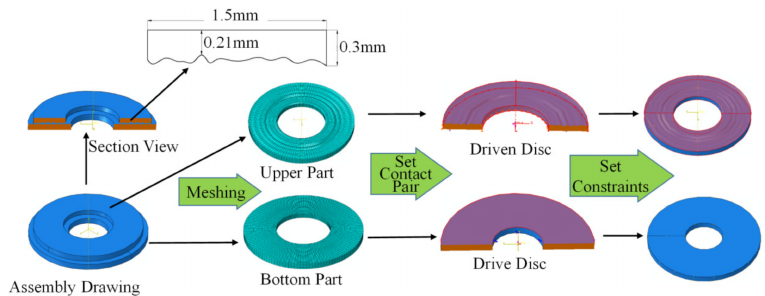
Figure 2. Modeling process of the friction pair. The 3D rough surface with grooves is generated by a 360-degree rotation of one 2-D topographic curve obtained by the fractal feature extraction above, and the distance between the rotational axis and the inner radius edge is 1.0 mm. We import the 3D rough surface model into the finite element analysis software ABAQUS as the upper part. The bottom part is simplified into a smooth disc. There is a clearance between the rough surface upper part and the bottom part when assembling. So, the two components constitute the whole ABAQUS friction pair model. The upper part has 16,640 elements, and the mesh type is C3D8R; the bottom part has 4914 elements, and the mesh type is the same as the upper part. The structural dimensions and material properties of the two parts are shown in Table 1, corresponding to the properties of the friction disc and steel disc in the wet clutch, respectively. As the bottom surface area is larger and its grid is coarser, the